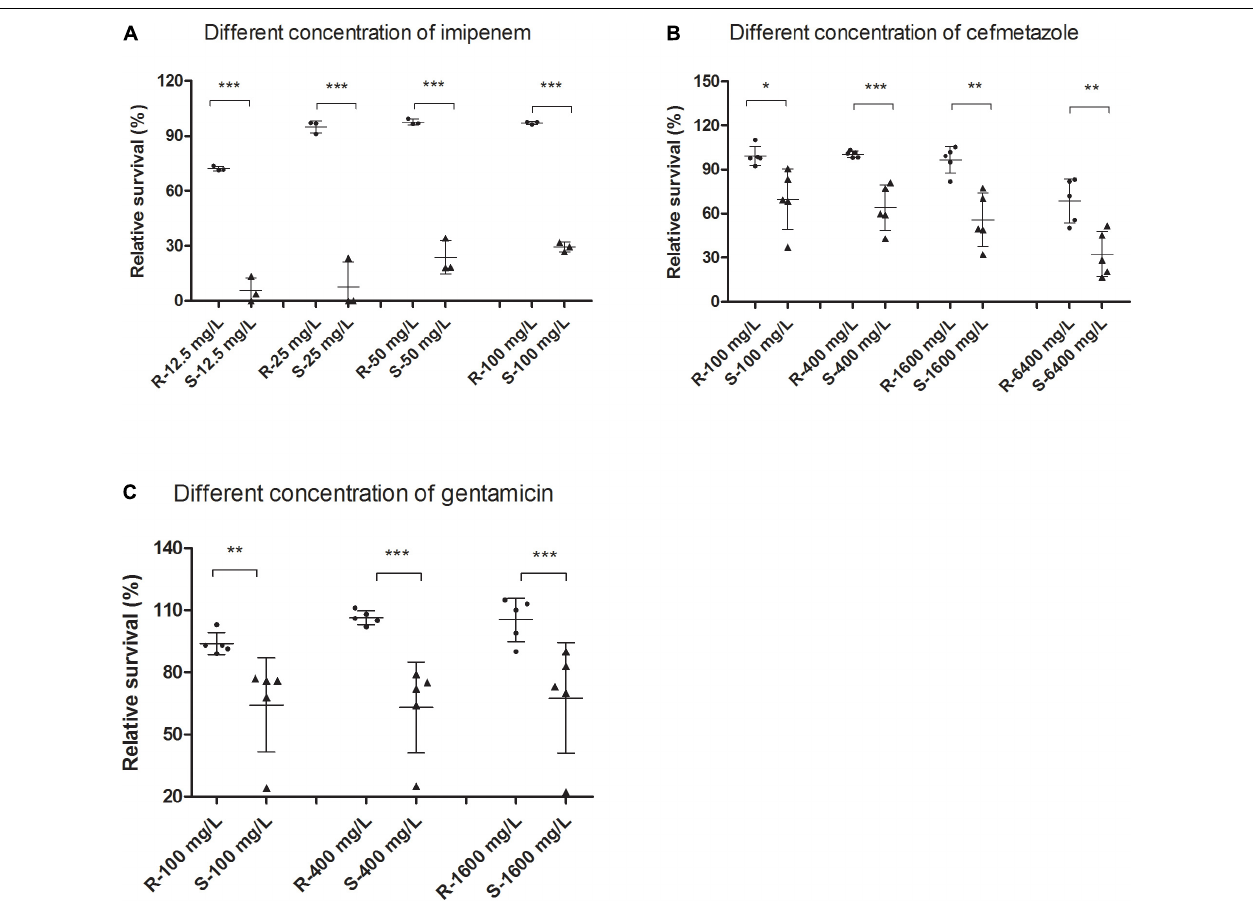
FIGURE 2 | Comparison of live or membrane impermeable cells measured by the SYBR Green/PI assay between resistant and susceptible Klebsiella pneumoniae isolates upon treatment of different concentrations of antibiotics. Clinical resistant and susceptible K. pneumoniae isolates were treated with different concentrations of (A) imipenem and (B) cefmetazole for 30 min. Log phase cultures of clinical resistant and susceptible K. pneumoniae isolates were treated with different concentrations of (C) gentamicin for 60 min. The cultures were then stained with SYBR Green/PI and measured fluorescence using a fluorescence plate reader. Relative membrane permeability rates were calculated from standard curves and compared between the resistant and susceptible groups at each concentration by t -test. * p < 0.05; ** p < 0.01; *** p <